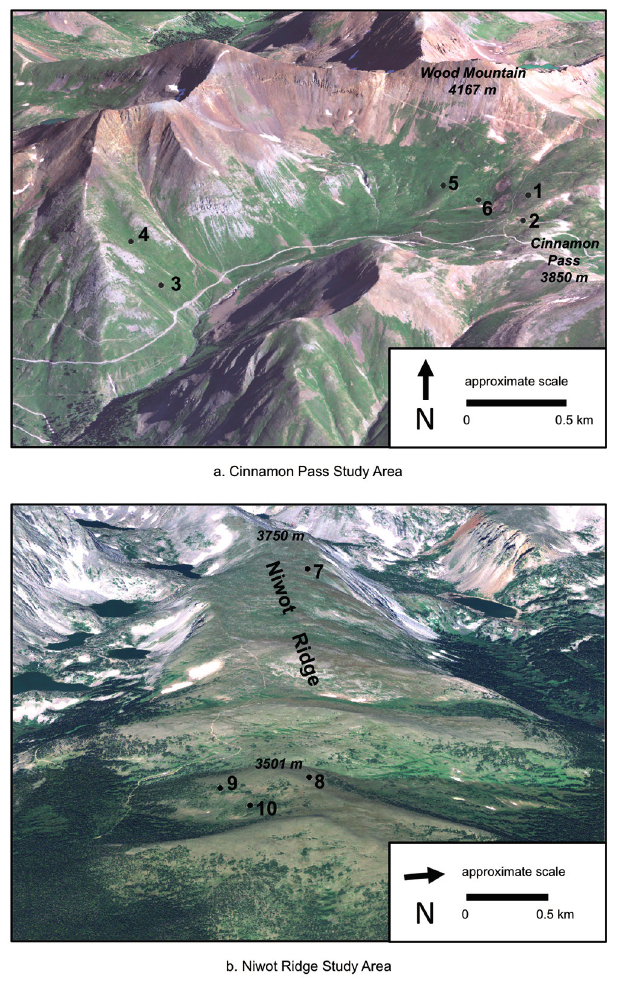
Figure 4. Locations for 60 × 60 m grid cells instrumented with arrays of temperature data loggers at ( a ) the Cinnamon Pass FSA and ( b ) the Niwot Ridge